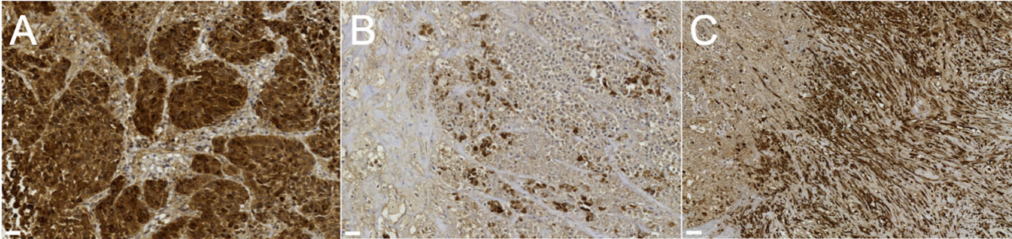
Figure 5. Photomicrographs of IHC-stained sections of the primary mammary gland tumor. ( A ) Strong di ff use positivity of the neoplastic parenchyma for panCK antibody (Ab); bar = 10 µ m. ( B ) Strong multifocal positivity of the neoplastic parenchyma for CK 5–6 Ab, bar = 10 µ m. ( C ) Strong di ff use positivity of the fibrovascular stroma for vimentin Ab; bar = 20 µ